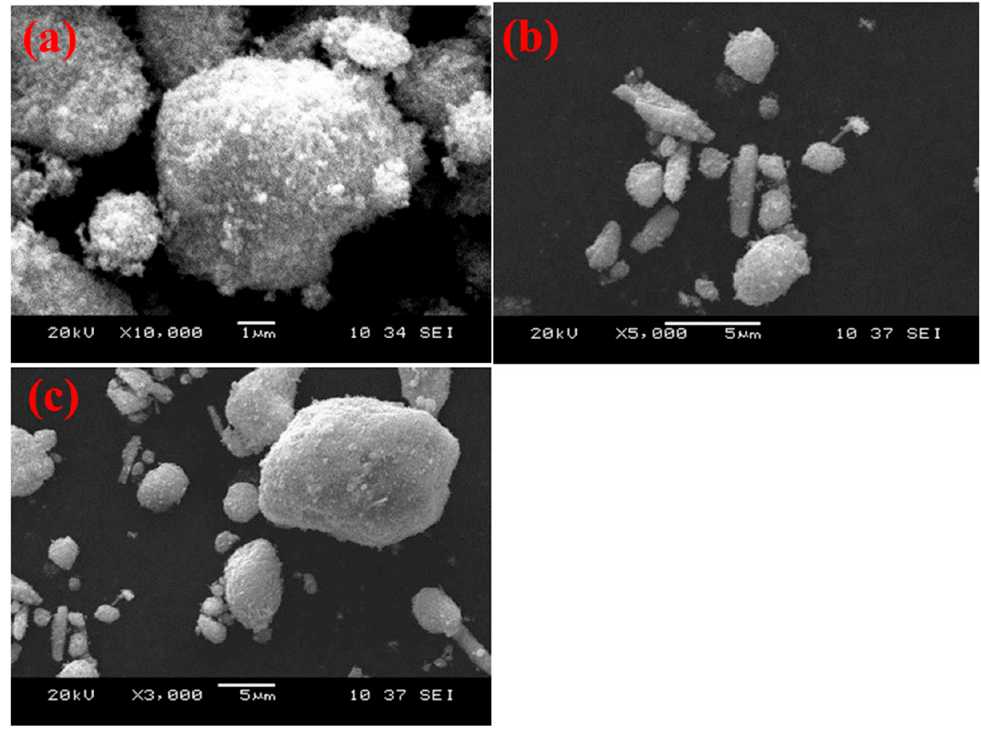
Figure 3. SEM images of SnO 2 ( a ), Co-SnO 2 NPs ( b ), and Co-SnO 2 /SGCN NCs ( c ).